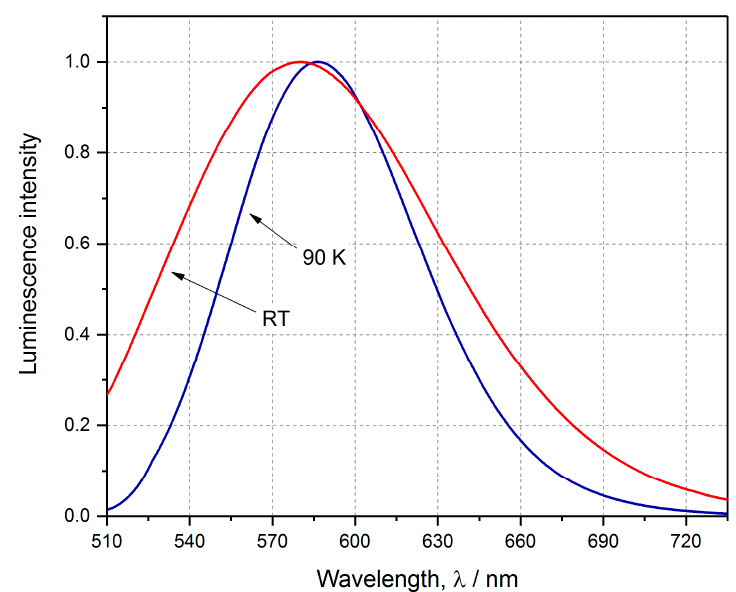
Figure 4. Emission spectra (smoothed and normalised) recorded for the Cu 6 crystal forms at 90 K and RT (excitation wavelength, λ ex = 355 nm). Table 4. The Cu 6 complex solid-state luminescence lifetimes ( τ ) and emission peak maxima ( λ em ) obtained from the least-squares fit at various temperatures ( T ). τ l and τ s denote longer and shorter lifetime, respectively.